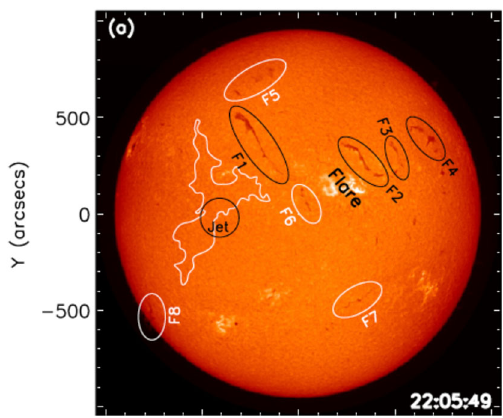
Fig. 1 H α image with the oscillating filaments, F1 – F4 , highlighted with black ellipses while the white ellipses indicate the nonoscillating ones, F5 – F8 . Image reproduced with permission from Shen et al. (2014a), copyright by